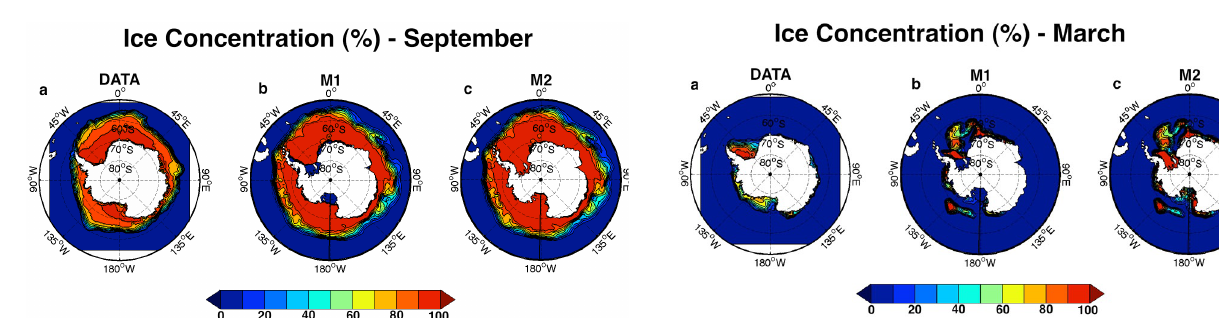
Fig. 11. Sea ice concentration in percentages for March (month of minimum sea ice coverage observed in the Southern Hemisphere) obtained from the (a) Nimbus-7 SMMR and DMSP SSM/I passive microwave data, (b) M1, and (c) M2